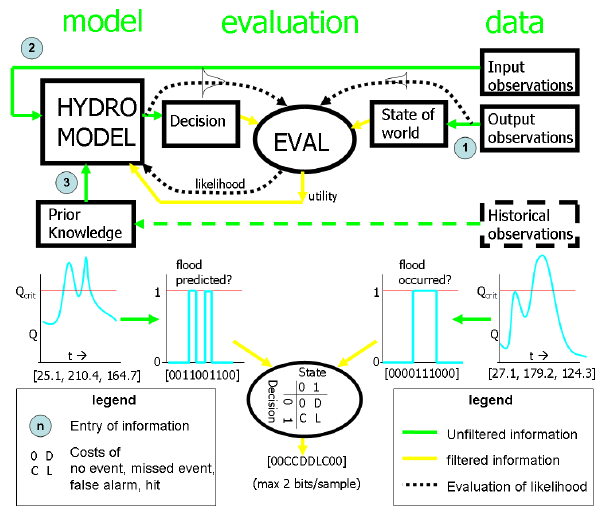
Fig. 3. There are three routes through which information can enter the model in a learning process: the output observations (1), the input observations (2) and prior information (3). When evaluating a model based on value, the decision model that is implicitly defined by the loss function acts as a filter on the information in the observations. The figure shows the case where both the decision and the state of the world are binary, resulting in a feedback of costs to the model of only 2 bits of information per input-output observa- tion pair (the string of characters at the bottom of the figure). The graphs in the middle show how both the predicted and the measured flows are converted to binary sequences due to the way the cost-loss model is formulated.